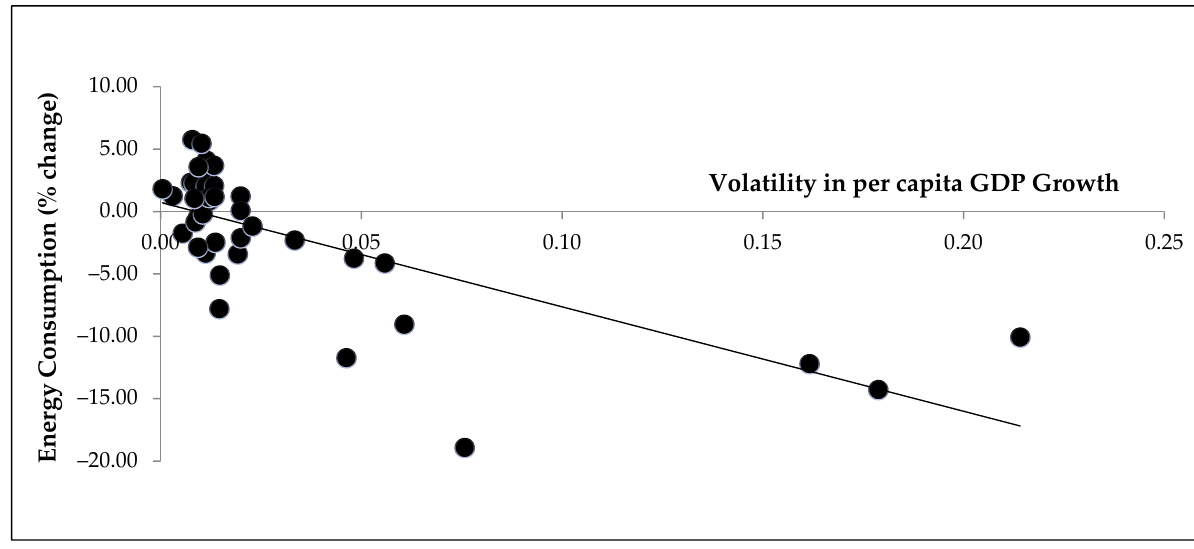
Figure 4. Per-capita income growth volatility and energy consumption growth (averages).